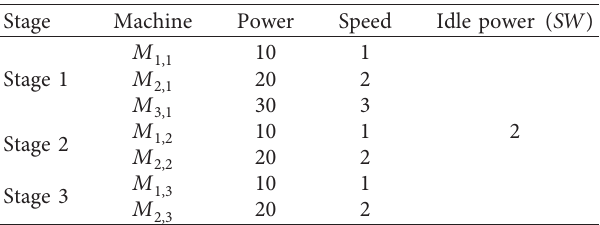
Table 2: Speed and power settings of all